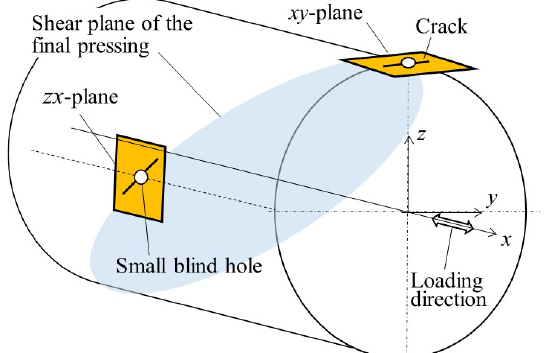
Figure 1: Illustration showing the location of the drilled hole as a crack starter, and the shear plane of the final ECAP pressing. The distribution of the grain sizes and grain boundary misorientation were determined by electron backscatter diffraction (EBSD) analysis. The specimens were ground using silicon carbide papers and polished with polycrystalline 3- and 1-  m diamond suspension. Final polishing was performed using a 0.04-  m colloidal silica suspension for 30–60 min. EBSD mappings were executed using a Tescan Mira II SEM incorporating an EDAX-TSL Hikari EBSD detector. Each hexagonally shaped pixel was 40 nm for the UFG copper samples and 1.0  m for the conventional grain-sized copper